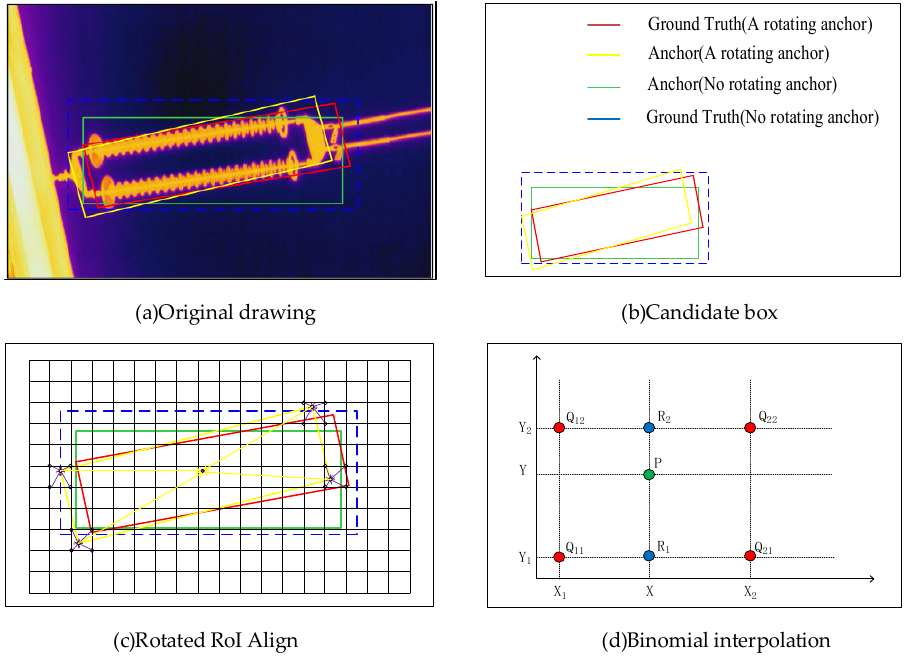
Figure 6. Rotational object refinement extraction module.